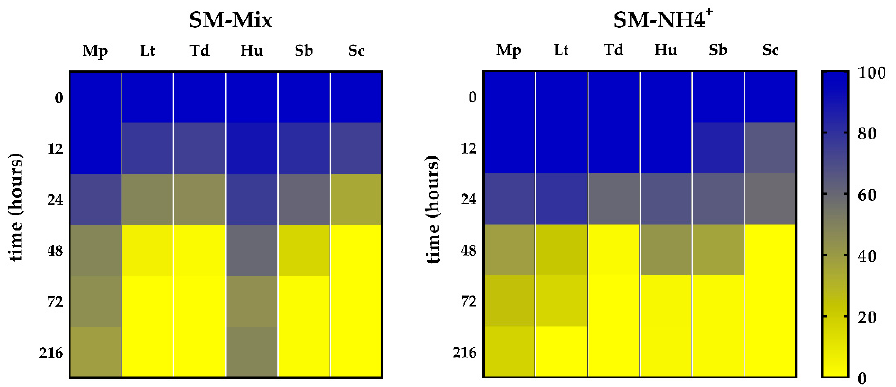
Figure 6. Ammonium concentration (%) present in the medium at di ff erent time points of the alcoholic fermentation in SM-Mix and SM-NH 4 + . The initial concentration of ammonium is expressed as 100%.